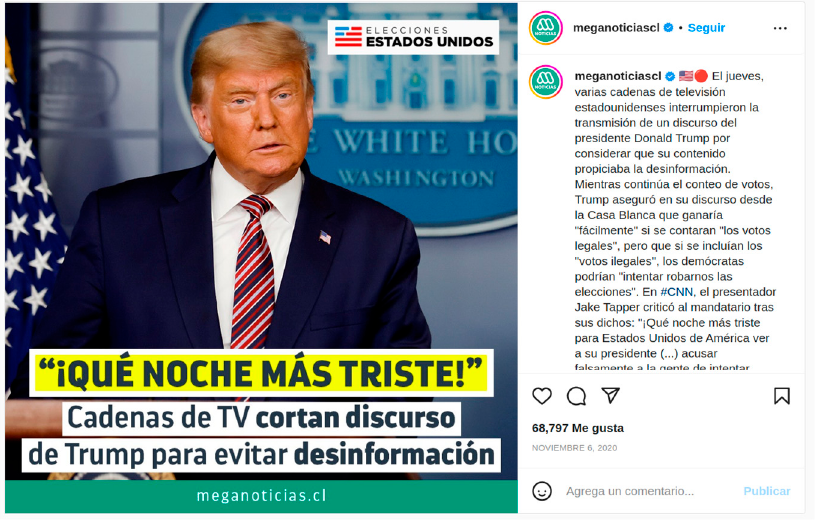
Figure 7. Exemplary case in Isntagram.